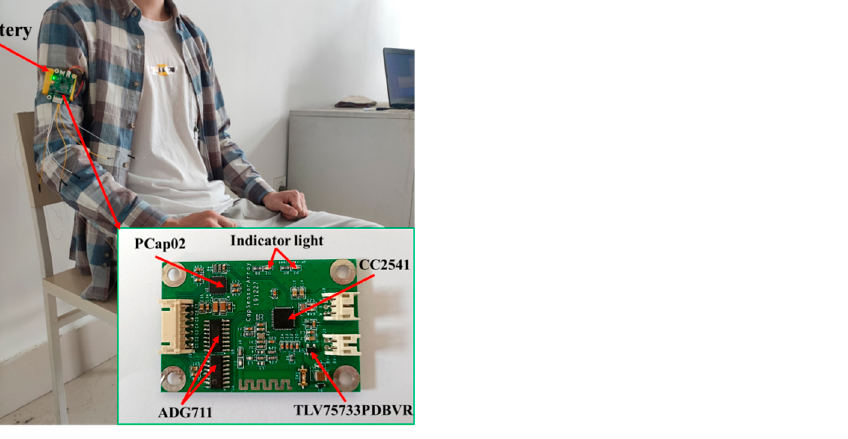
Figure 13. Capacitance response of the sensor in different motion states. The sensor capacitance changes in the state of ( a ) sitting, ( b ) standing still, ( c ) walking, and ( d ) running.